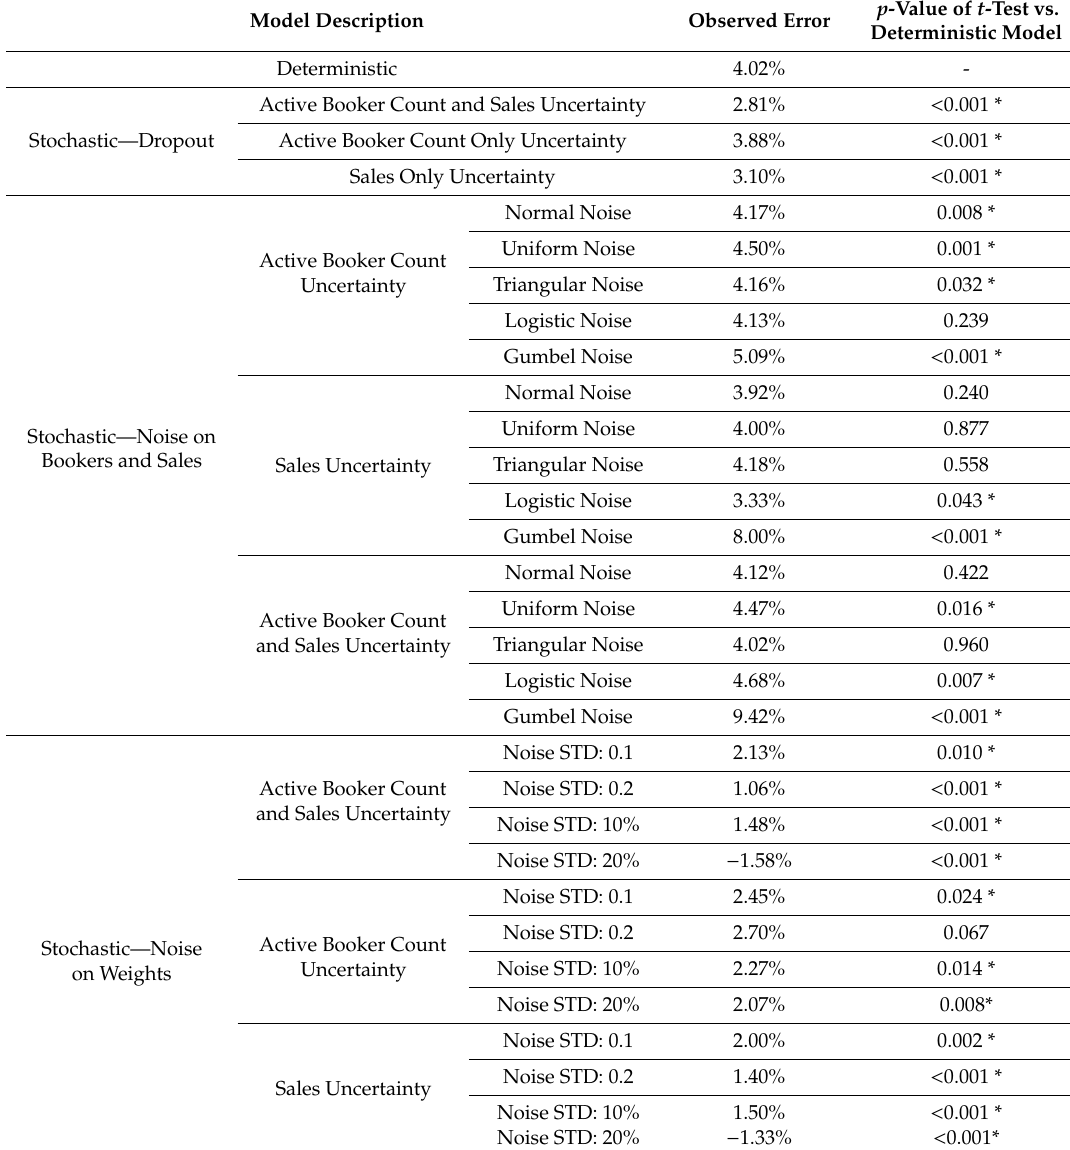
Table 1. Summary of sales forecast predictions for various approaches. * represents cases where the predictions are statistically significantly di ff erent from those of the deterministic